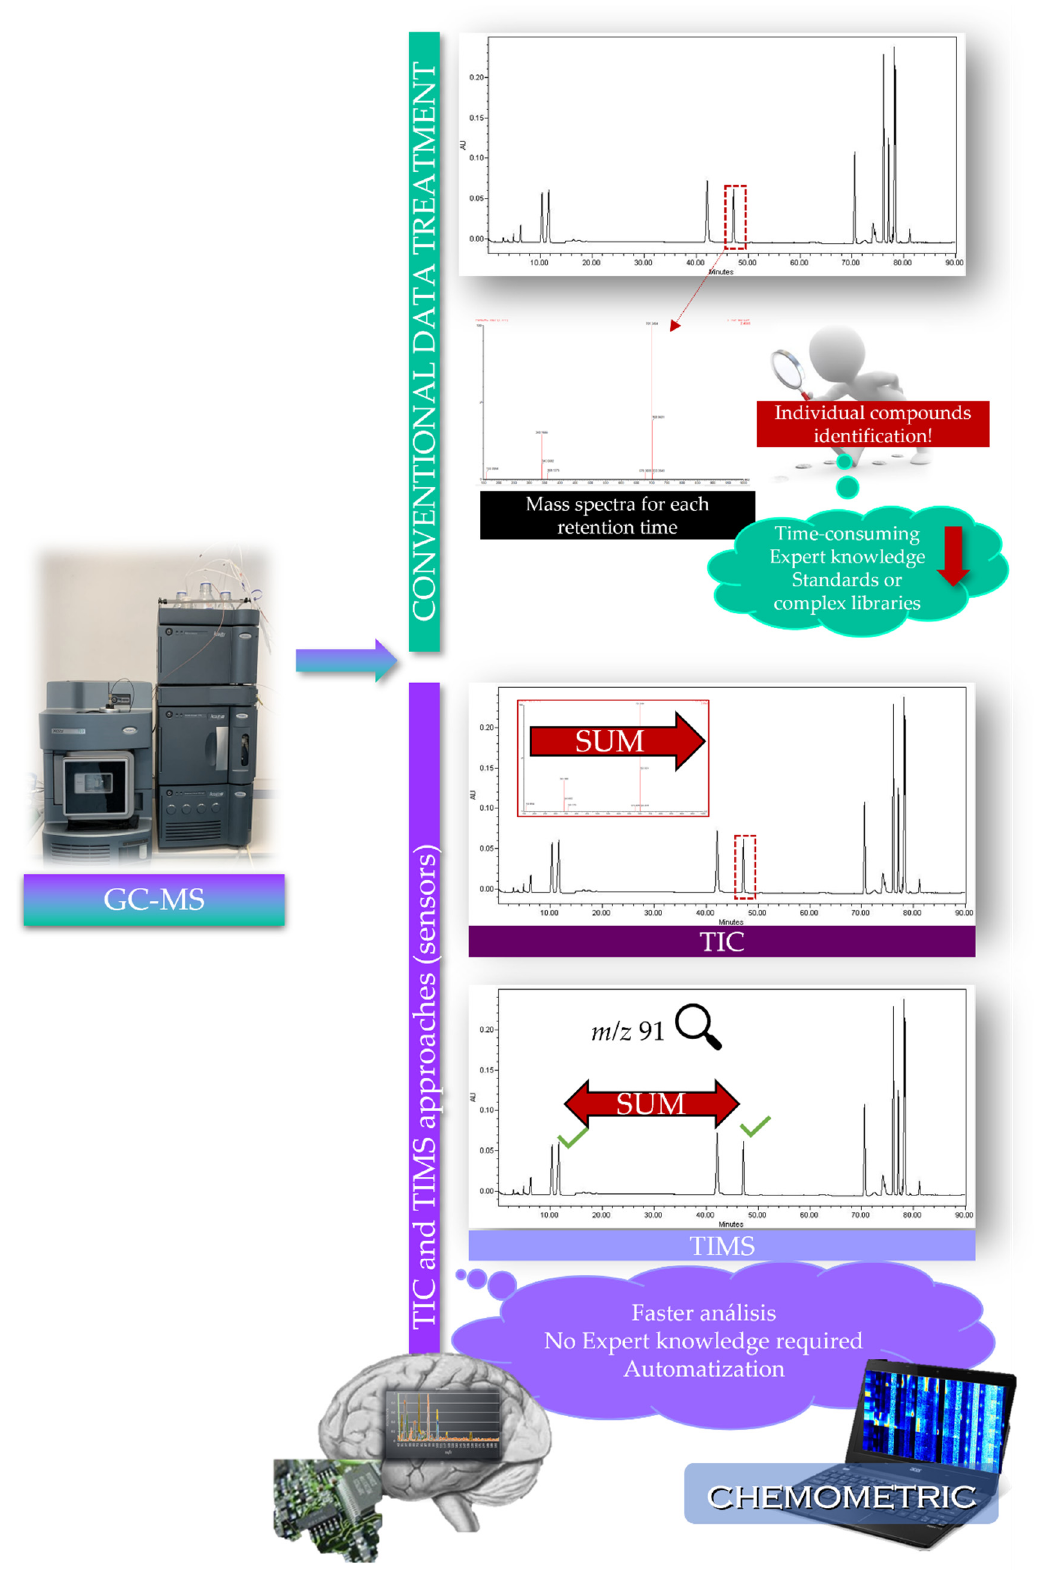
Figure 1. Schematic representation of the TIC and TIMS approaches and their advantages.